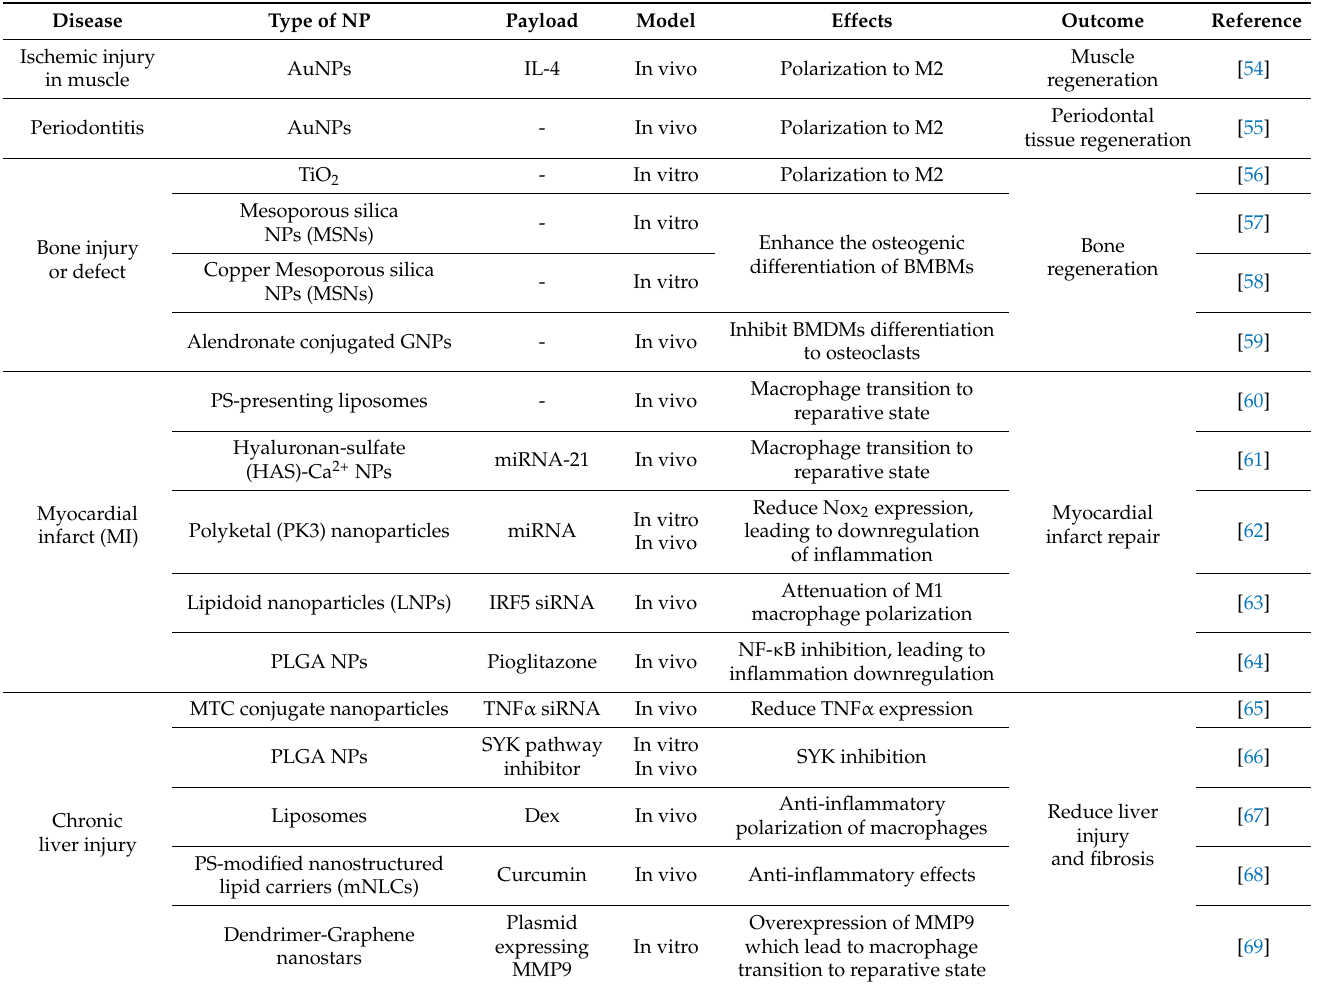
Table 2. Nanoparticle-based strategies to modulate macrophages for tissue